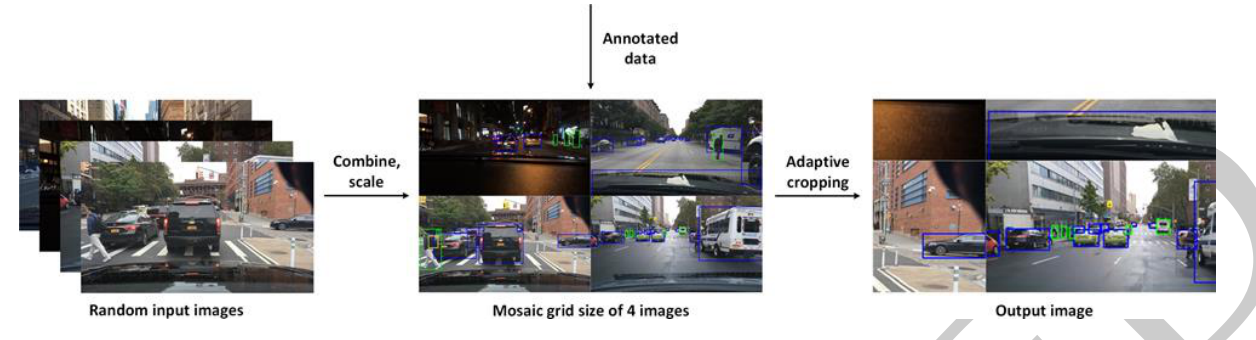
Figure 9. Implementation of the Mosaic data Augmentation.